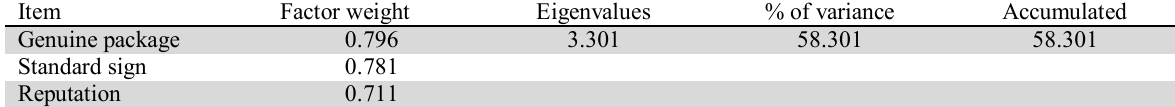
The summary of factors influencing on product validation